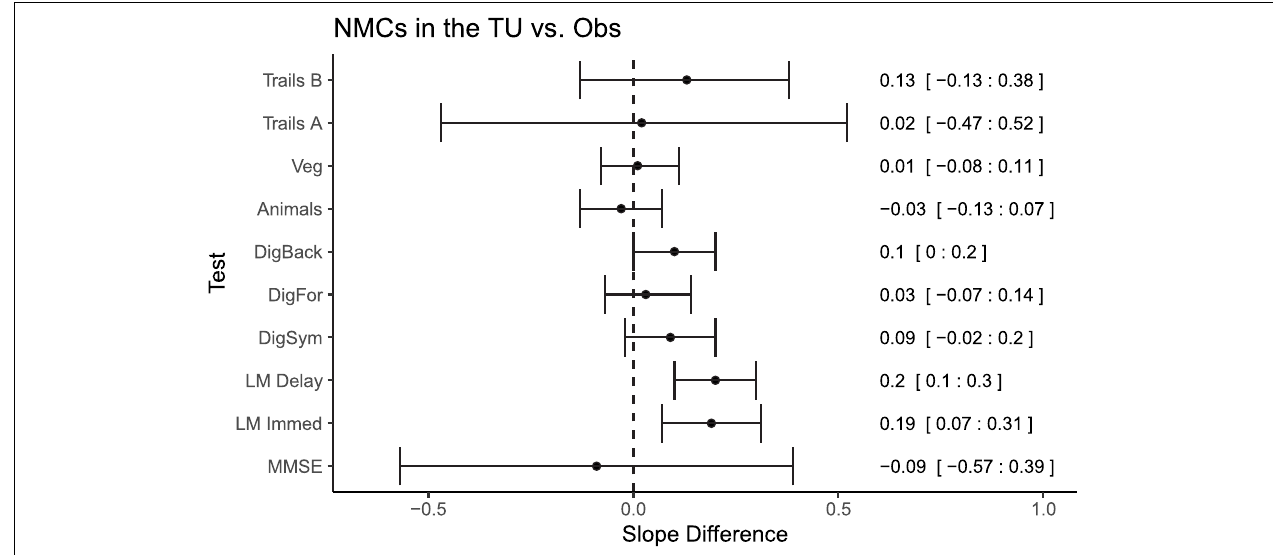
FIGURE 6 | Differences in slopes (and 95% CIs) for each test between non-mutation carriers in TU vs. the Obs study. A positive slope difference indicates a larger or more positive slope (improvement) in the TU compared to the Obs study. Some tests, such as Logical Memory had more improvement or practice effects in the TU vs. Obs. Mean differences and 95% CIs presented along the right side of the